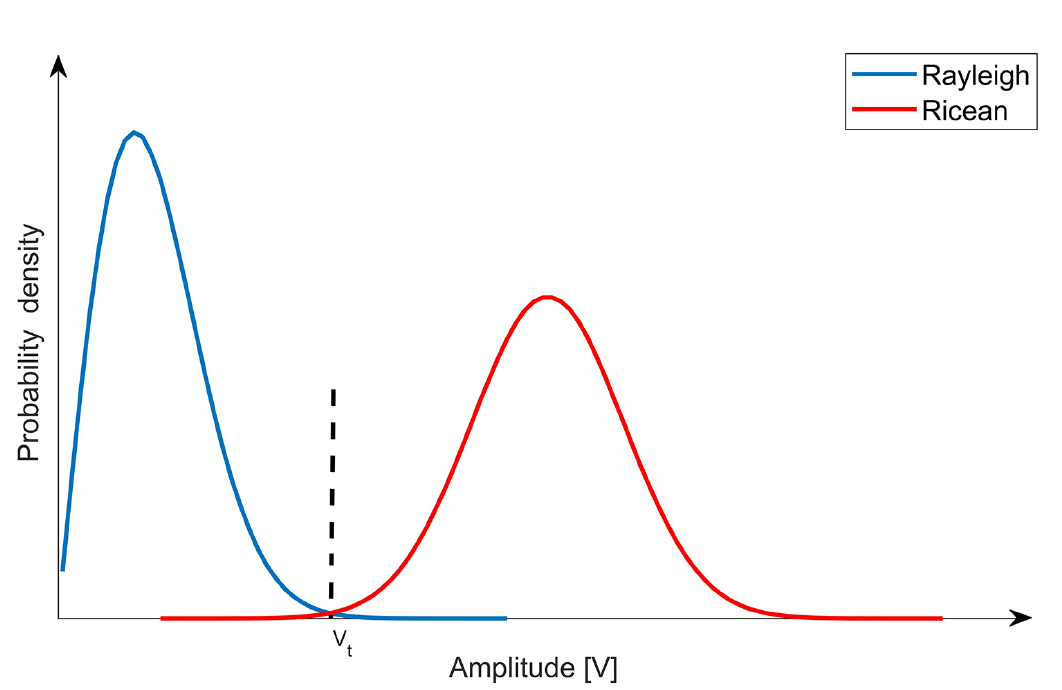
Figure 4. Incoherent integral probability